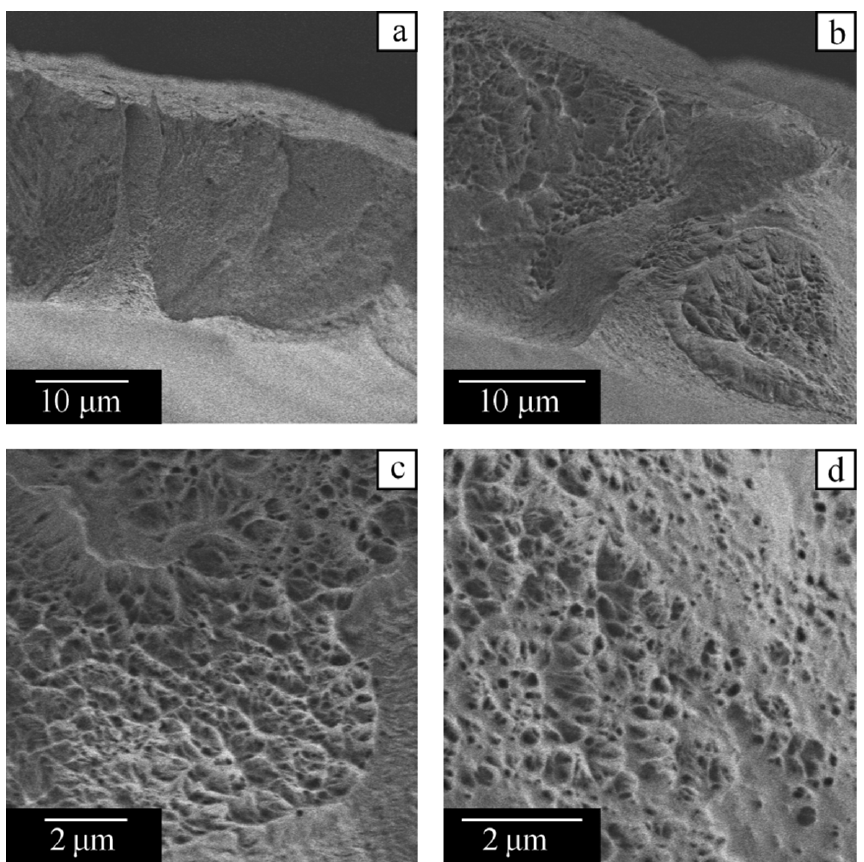
Figure 14. SEM images of the capillary-porous body obtained from the PVDF–camphor mixture containing 67 wt% of the polymer. Note the scale bars in the images ( a − d ).